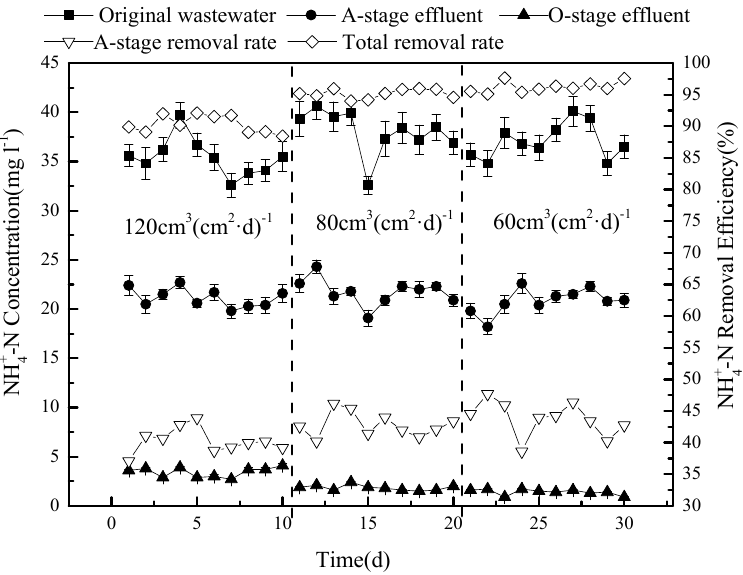
Figure 7. Variation in NH 4+ -N concentration ( top ) and removal efficiency ( bottom ) under the three different hydraulic loads.